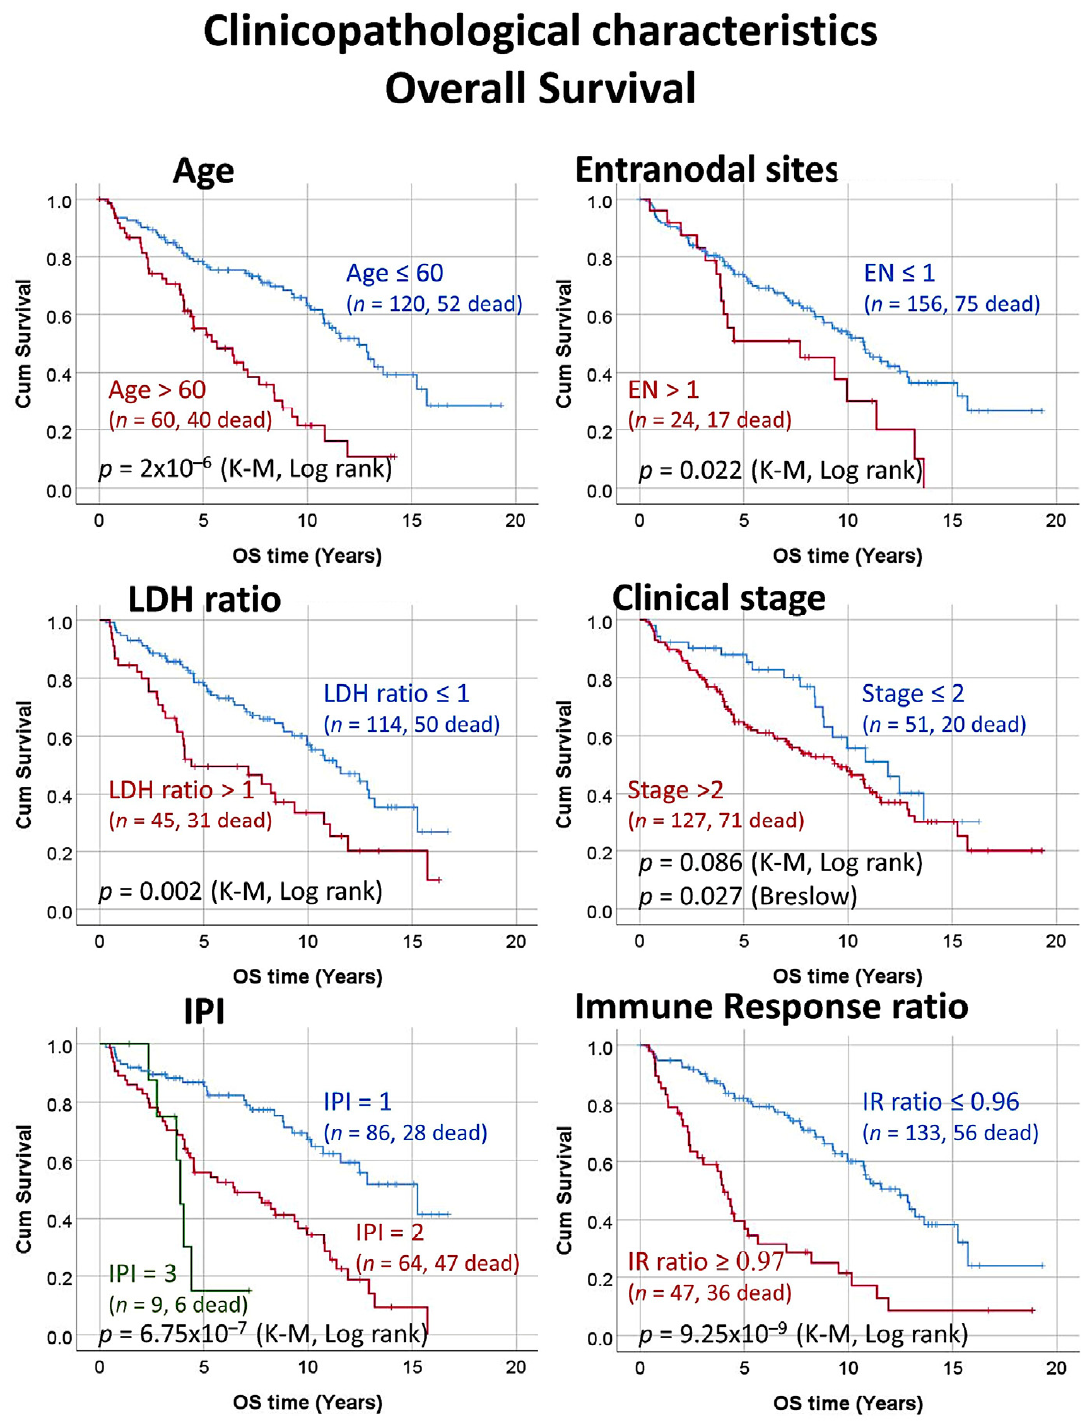
Figure 3. Clinicopathological characteristics of the series. Correlation between the clinicopathological